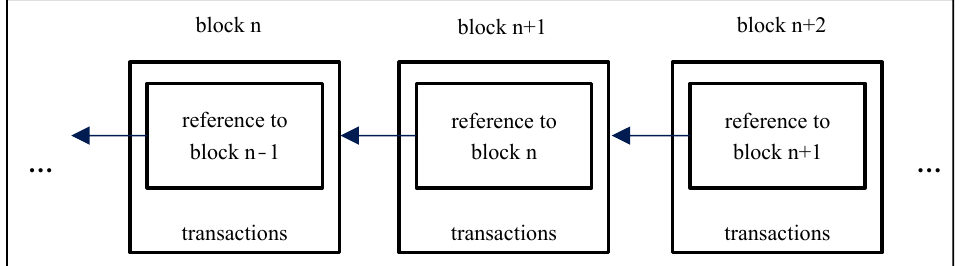
Figure 1. Schematic representation of the structure of a Blockchain [12] (p. 2293) (slightly modified).